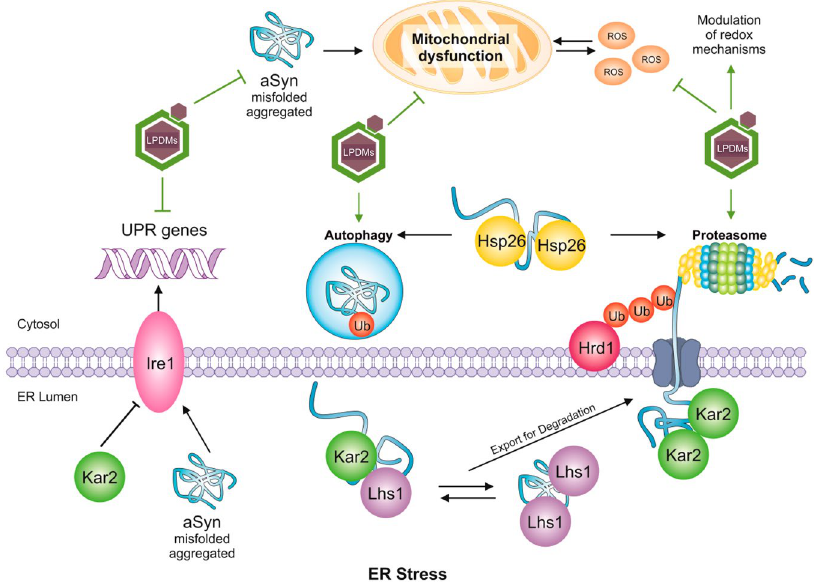
Figure 6. Schematic representation of the mechanism of aSyn toxicity and protection by A. unedo LPDMs. Accumulation of unfolded proteins (such as aSyn) or oxidative stress leads to endoplasmic reticulum (ER) stress with activation of the unfolded protein response (UPR), leading to oligomerization of the kinase Ire1, and transcription of genes related with protein-folding homeostasis. Kar2 is a negative regulator of UPR via interaction with Ire1. When unfolded proteins accumulate Kar2 is displaced from Ire1, to act as a chaperone aiding proteins conformation. Direct activation of Ire1 by unfolded proteins is an alternative mode for UPR induction. Lhs1, an ER chaperone, mediates protein folding and interacts with Kar2. Cytosolic chaperones also assist aSyn conformation, as Hsp26. Proteins failing to be correctly folded are exported from the ER, a process involving Kar2. Hrd1 is an ubiquitin ligase responsible for recognizing and ubiquitinating misfolded proteins. Afterward ubiquitination, proteins are either degraded in the cytosol by the proteasome or by autophagy, pathways that are both upregulated by the UPR. Aggregated aSyn induces reactive oxygen species (ROS) production and elicits ER stress, with concomitant induction of UPR gene expression. Our findings showed that LPDMs reduced aSyn aggregation and the induction of UPR, while promoting autophagy and proteasome function, pathways involved in aSyn degradation. Moreover, LPDMs reduced oxidative stress and mitochondrial dysfunction, by modulation of redox homeostasis. Overall, LPDMs increased cell viability by a pleiotropic protective